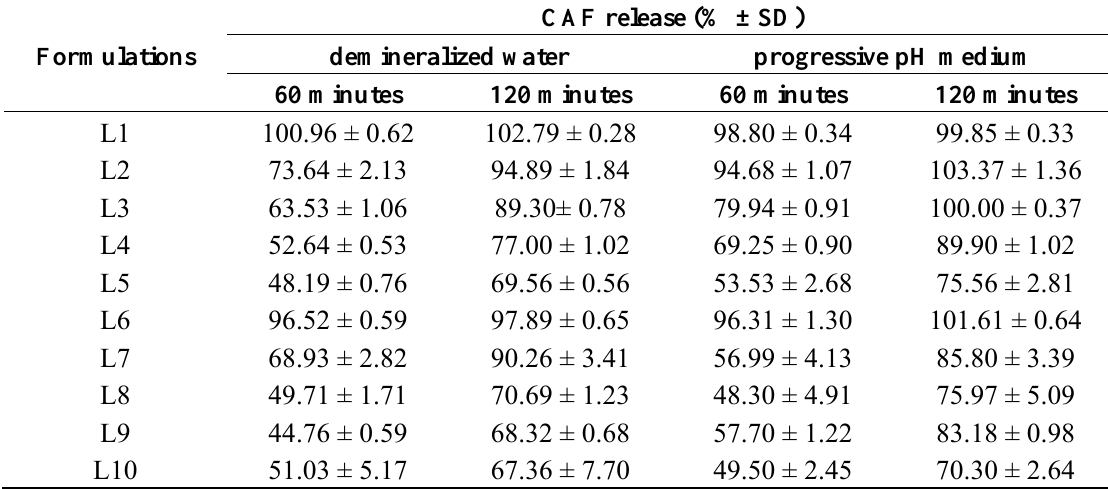
Table 3. Caffeine released in both media from lyophilized systems at measured time intervals of 60 and 120